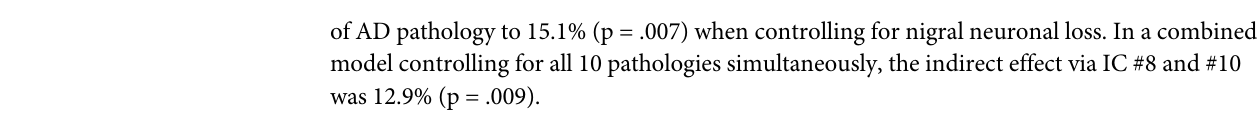
Fig 3. Graphical depiction of path analysis with R 2 ICs as mediators linking physical activity and cognition. Standardized path coefficients are shown, along with their respective p-values. This analysis also controlled for participants’ age at death, sex, and education (not shown in this figure).